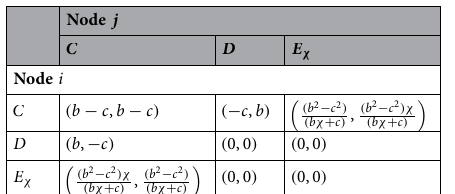
Table 1. Long-term payoff matrix of gift giving game involving extortion